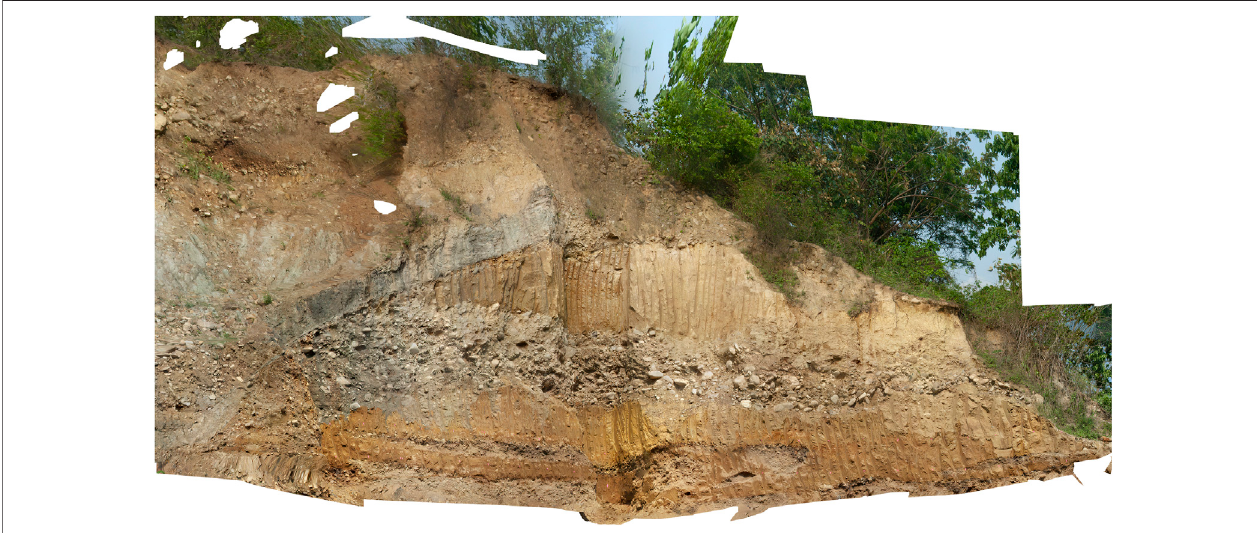
FIGURE3| Theorthorecti fi edphotomosaic oftheoutcrop(seealsotheassociated SupplementaryVideoS1 )wasconstructedwithAgisoftMetashapesoftware using 136 fi eld photographs. The MFT, i.e., the TFT, crosses the Dungsam Chu at 26.79194 ° N, 91.51085 ° E.